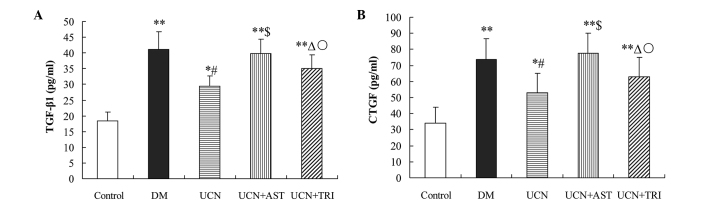
Urocortin and urocortin with triciribine reduced the oversecretion of (A) TGF-β1 and (B) CTGF in the plasma of diabetic rats. However, astressin reversed the effect of urocortin. *P<0.05 and **P<0.01, vs. control; #P<0.01 and ΔP<0.05, vs. DM and UCN + AST groups; $P>0.05, vs. DM group; ○P<0.05, vs. UCN group. TGF, transforming growth factor; CTGF, connective tissue growth factor; DM, diabetes mellitus; UCN, urocortin; AST, astressin.